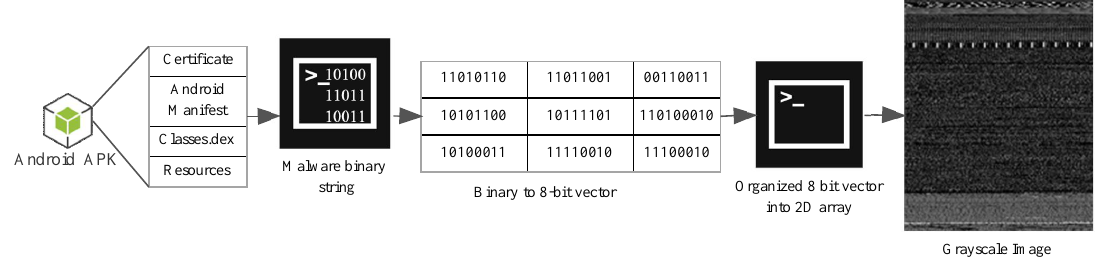
Figure 3. Conversion process of APK into grayscale